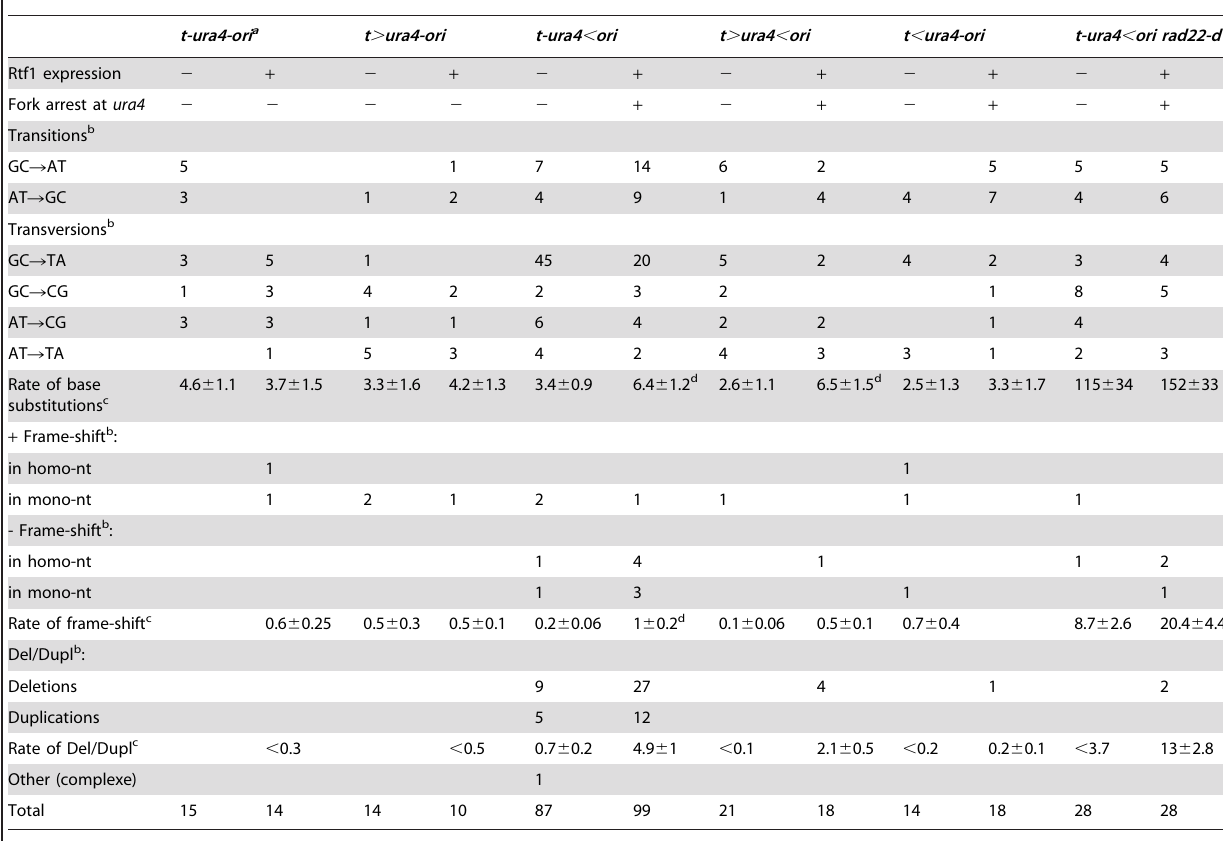
Table 2. Mutations spectra in the indicated